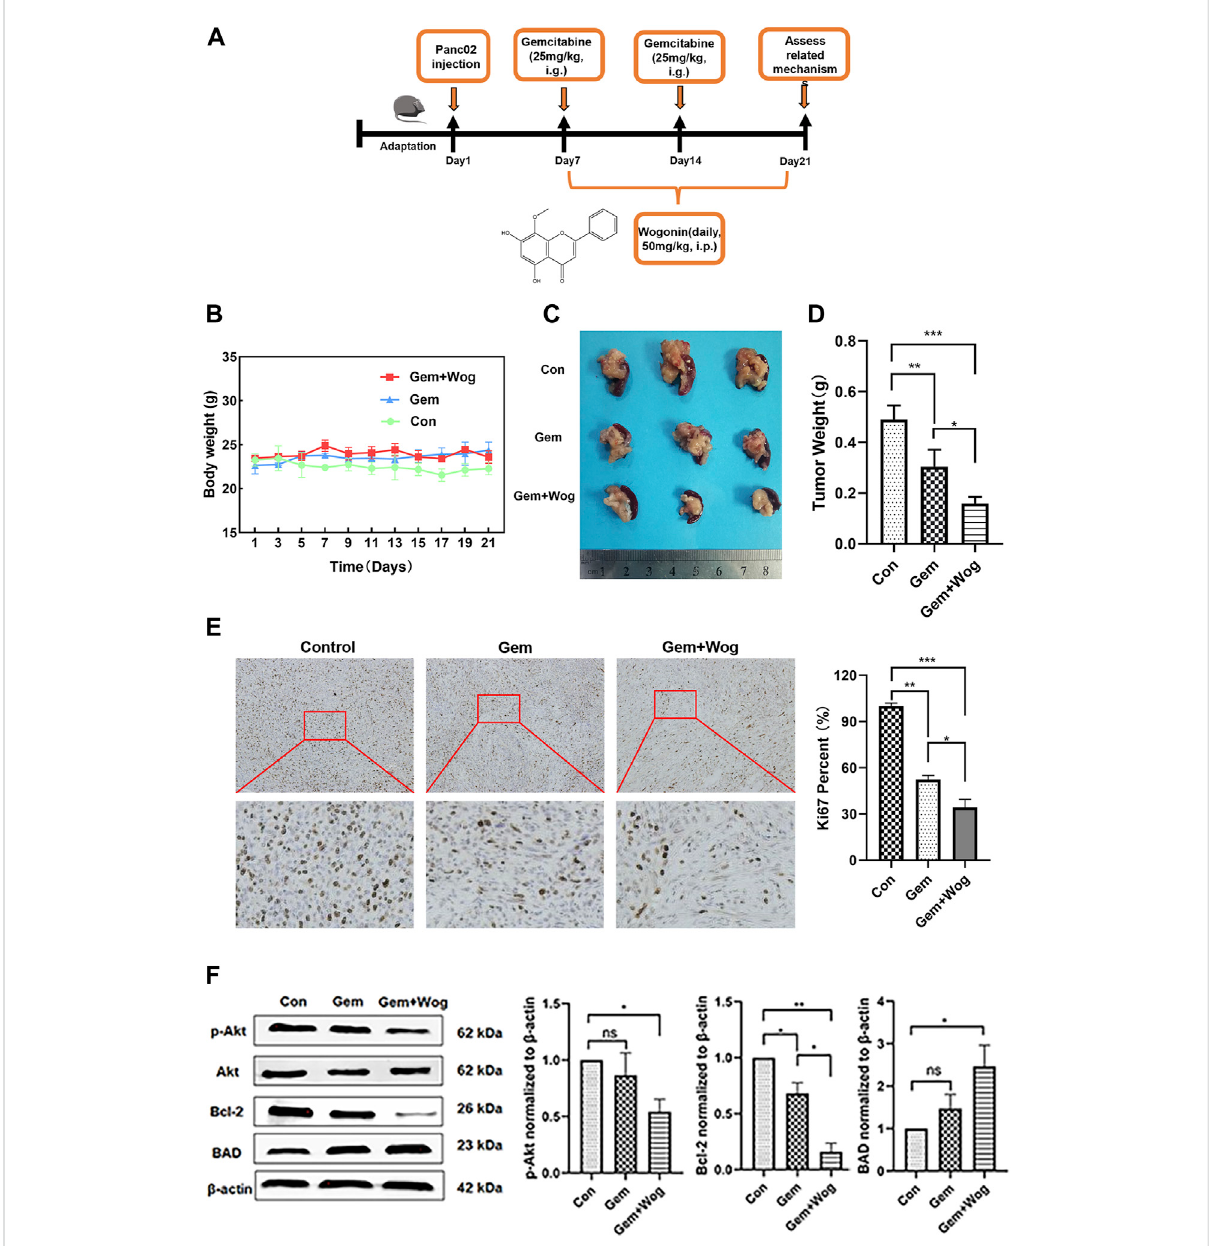
FIGURE 5 Wogonin inhibitd pancreatic cancer in vivo by inhibiting Akt pathway (A) Orthotopic pancreatic cancer mouse model experimental design (B) BodyweightchangesofmiceinCongroup,GemgroupandGem+Woggroupwithin21 days (C) Tumorsize (D) Tumorweight (E) The fi xedsections of mouse pancreas and pancreatic cancer were stained with Ki67 to detect tumor proliferation (F) After cryopreservation of mouse pancreatic tumors, Western Blot was detected to compare the expression of p-AKT, AKT, BAD and bcl-2 proteins in Con group, Gem group and Gem